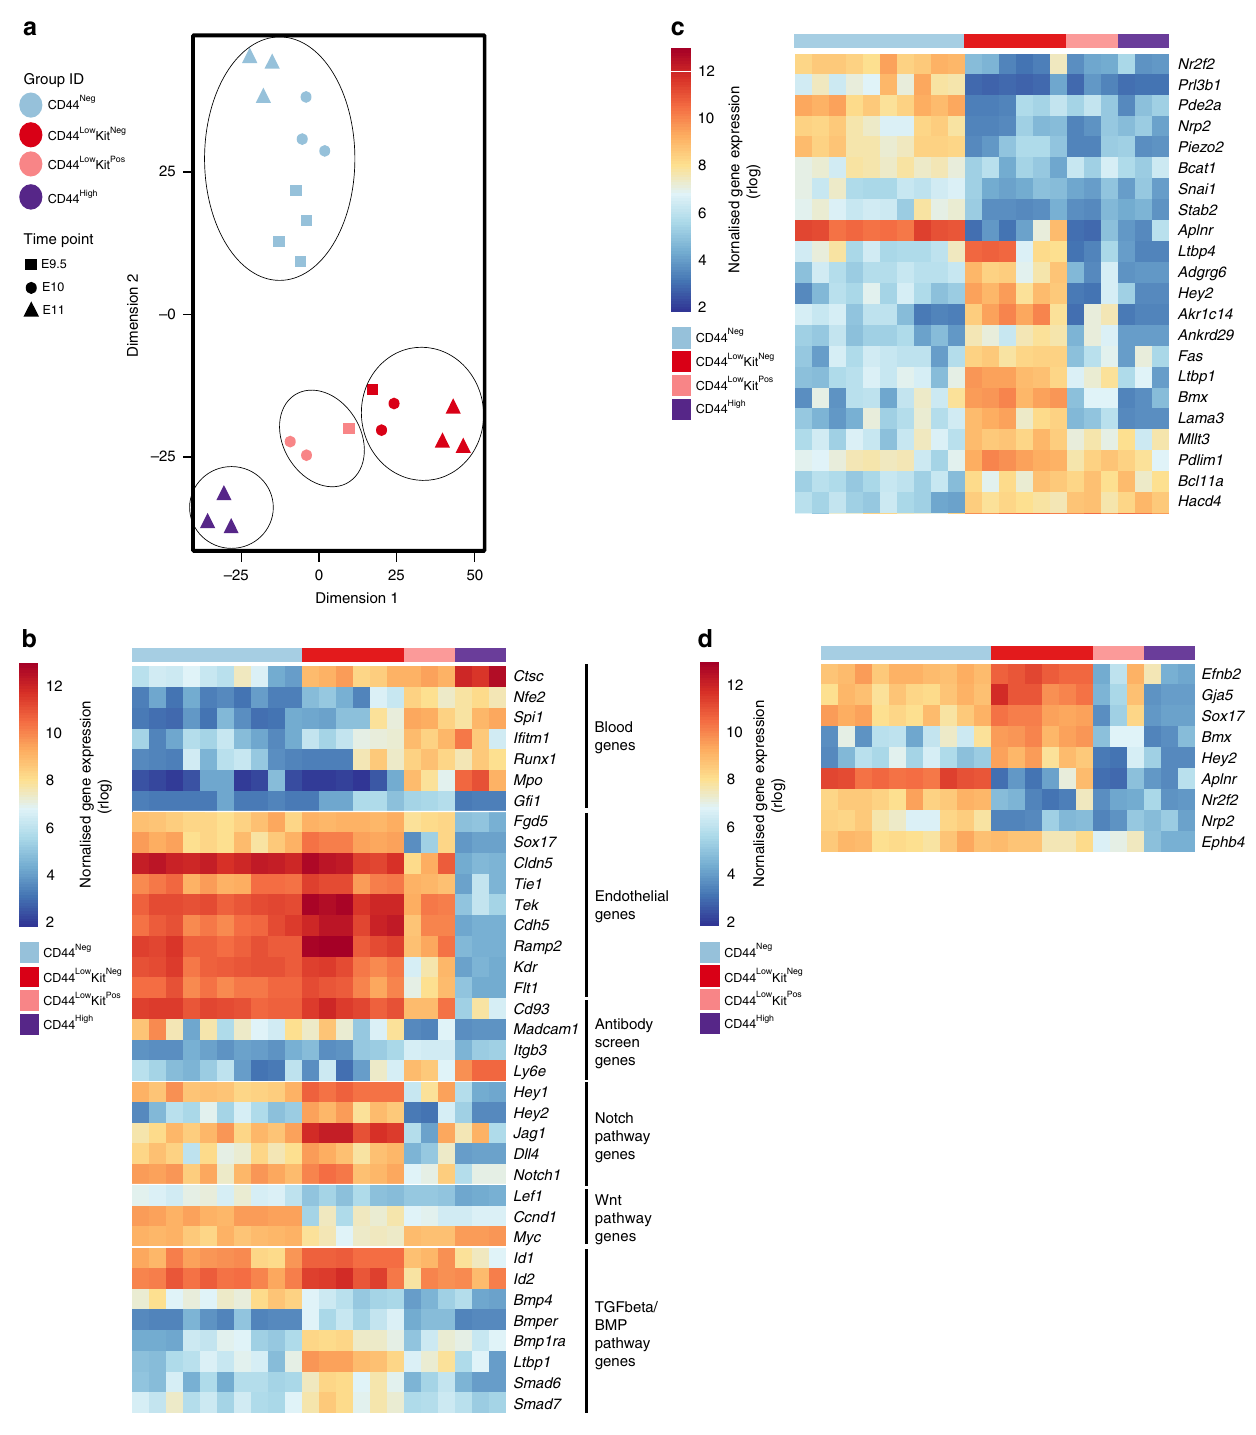
Fig. 5 Bulk RNA sequencing identi fi es early changes in the EHT process. a tSNE plot from 25-cell bulk RNA sequencing generated from E9.5, E10 and E11 AGM. Four groups are indicated. b Heatmap of gene expression highlighting a selection of genes. c Heatmap of gene expression highlighting the most differentially expressed genes between CD44 Neg and CD44 Low Kit Neg endothelial populations ( p -value < 0.01). d Heatmap of gene expression highlighting arterial ( Efbn2 , Gja5 , Sox17 , Bmx and Hey2 ) and venous ( Aplnr , Nr2f2 , Nrp2 and Ephb4 ) coding genes in CD44 Low Kit Neg and CD44 Neg populations. See also Supplementary Data Runx1 is dispensable for the formation of CD44 Low Kit Neg . processes accompanying autophagy, ubiquitylation and proteolysis, were also upregulated. As autophagy has been shown to play a key CD44 has allowed us to clearly de fi ne the key VE-Cad + populations in the AGM. The transcription factor RUNX1 is role in embryonic development and haematopoiesis 35 – 37 , this provides further support to the CD44 Low Kit Neg cells being in transit essential for HSPC formation and is known to downregulate from endothelial to haematopoietic identity. endothelial identity through its target genes G fi 1 and G fi 1b 10,38 .